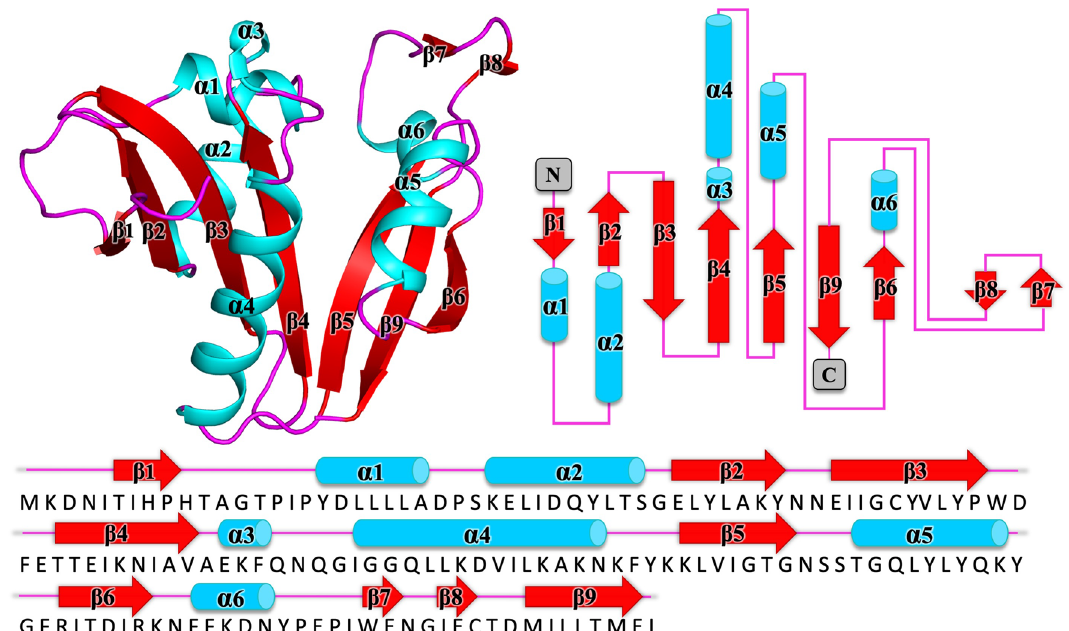
Figure 1. Tertiary structure the GNAT acetyltransferase from Elizabethkingia anophelis . Top left, shown in cartoon format, α-helices, β-strands, and loops are shown in cyan, red, and magenta, respectively. Top right, topology map of the GNAT acetyltransferase from Elizabethkingia anophelis with α-helices shown as cylinders colored in cyan, β-strands are presented as red arrows, and loops are shown with magenta. Bottom